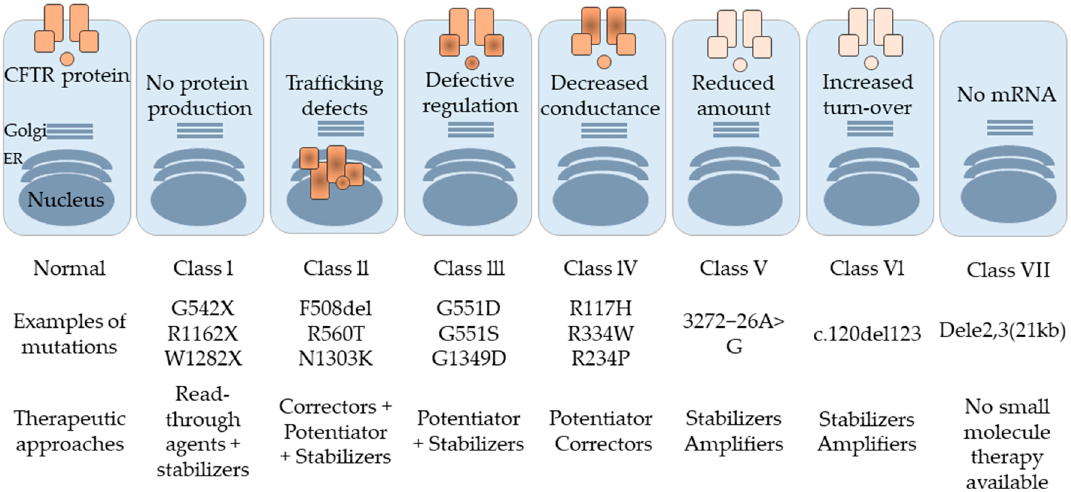
Figure 3. Different classes of CFTR mutations along with the possible therapeutic approach for each class.